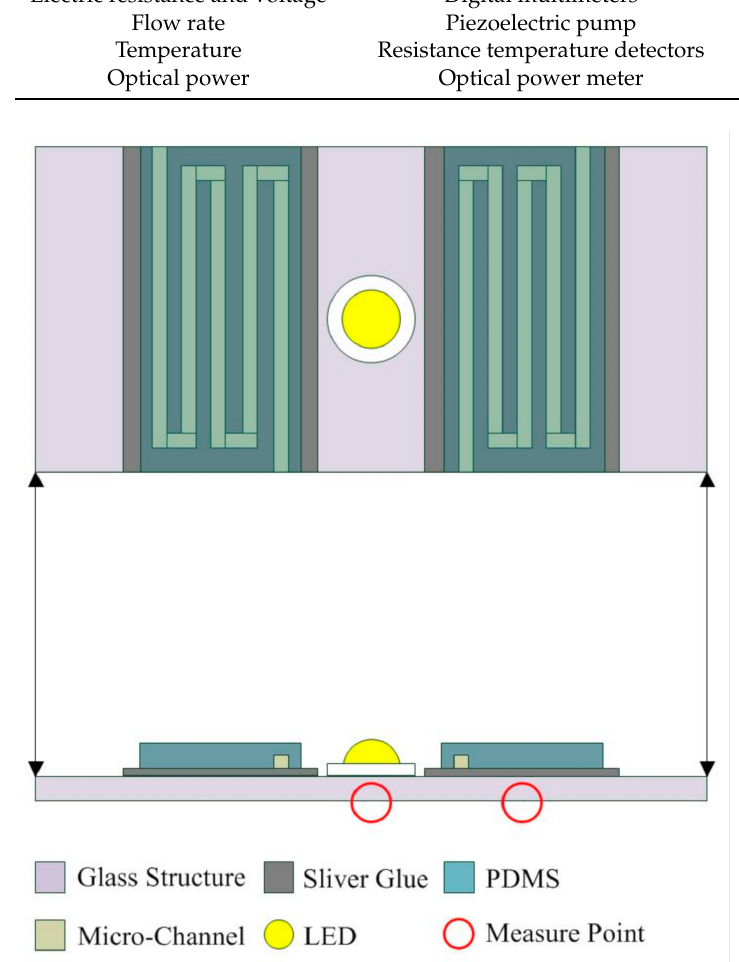
Figure 5. Schematic of the temperature measurement points of the LED bottom and microfluidic